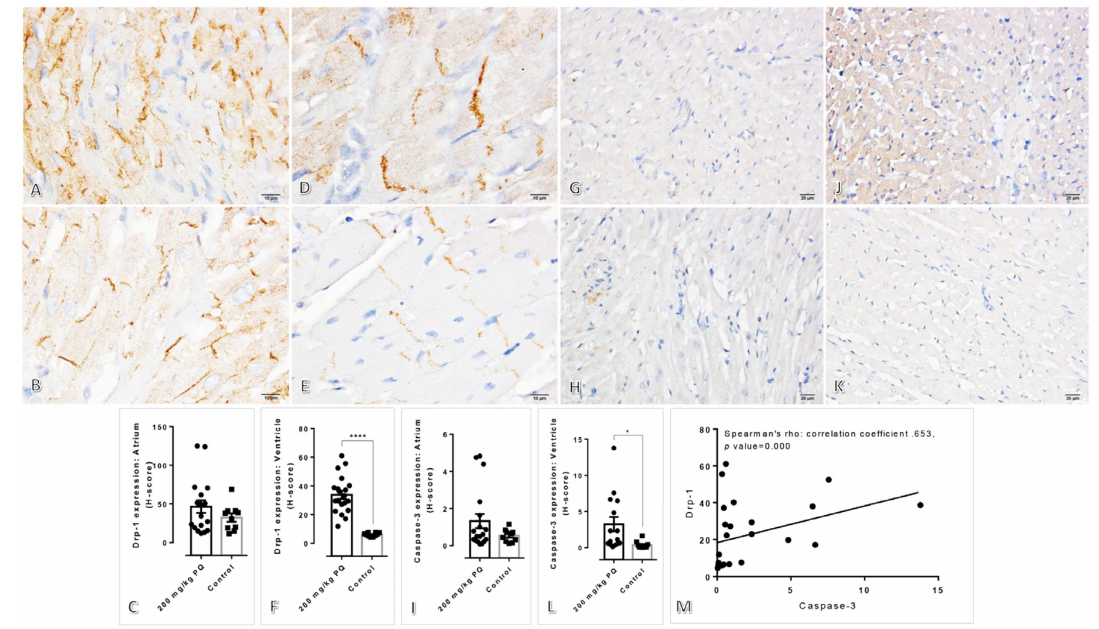
Figure 5. Immunohistochemical staining for cardiac Drp-1 and caspase-3 in rat-treated with or without 200 mg/kg of PQ: ( A – F ) Atrium and ventricle immunolabeling of Drp-1 in rats treated with ( A , D ) or without ( B , E ) 200 mg/kg of PQ. ( G – L ) Atrium and ventricle immunolabeling of caspase-3 in rats treated with ( A , D ) or without ( B , E ) 200 mg/kg of PQ. ( M ) The Spearman’s correlation test between the level of Drp-1 and caspase-3 in the cardiac mitochondria both rats treated with or without 200 mg/kg of PQ. For subsequent figures, statistical significance of comparisons is *, p < 0.05; and ****, p < 0.00001.